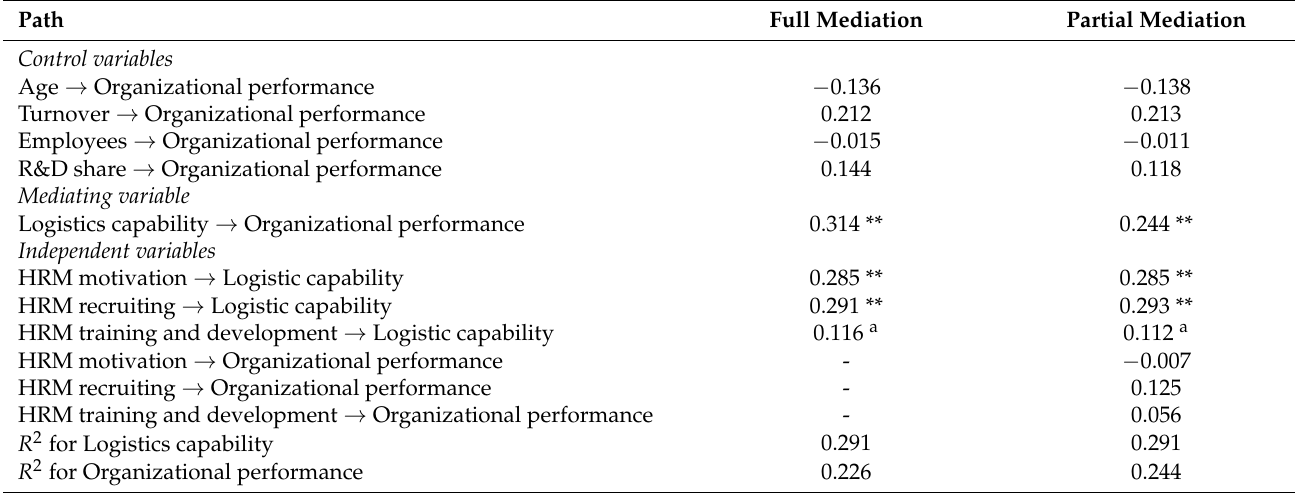
Table 3. Research models.